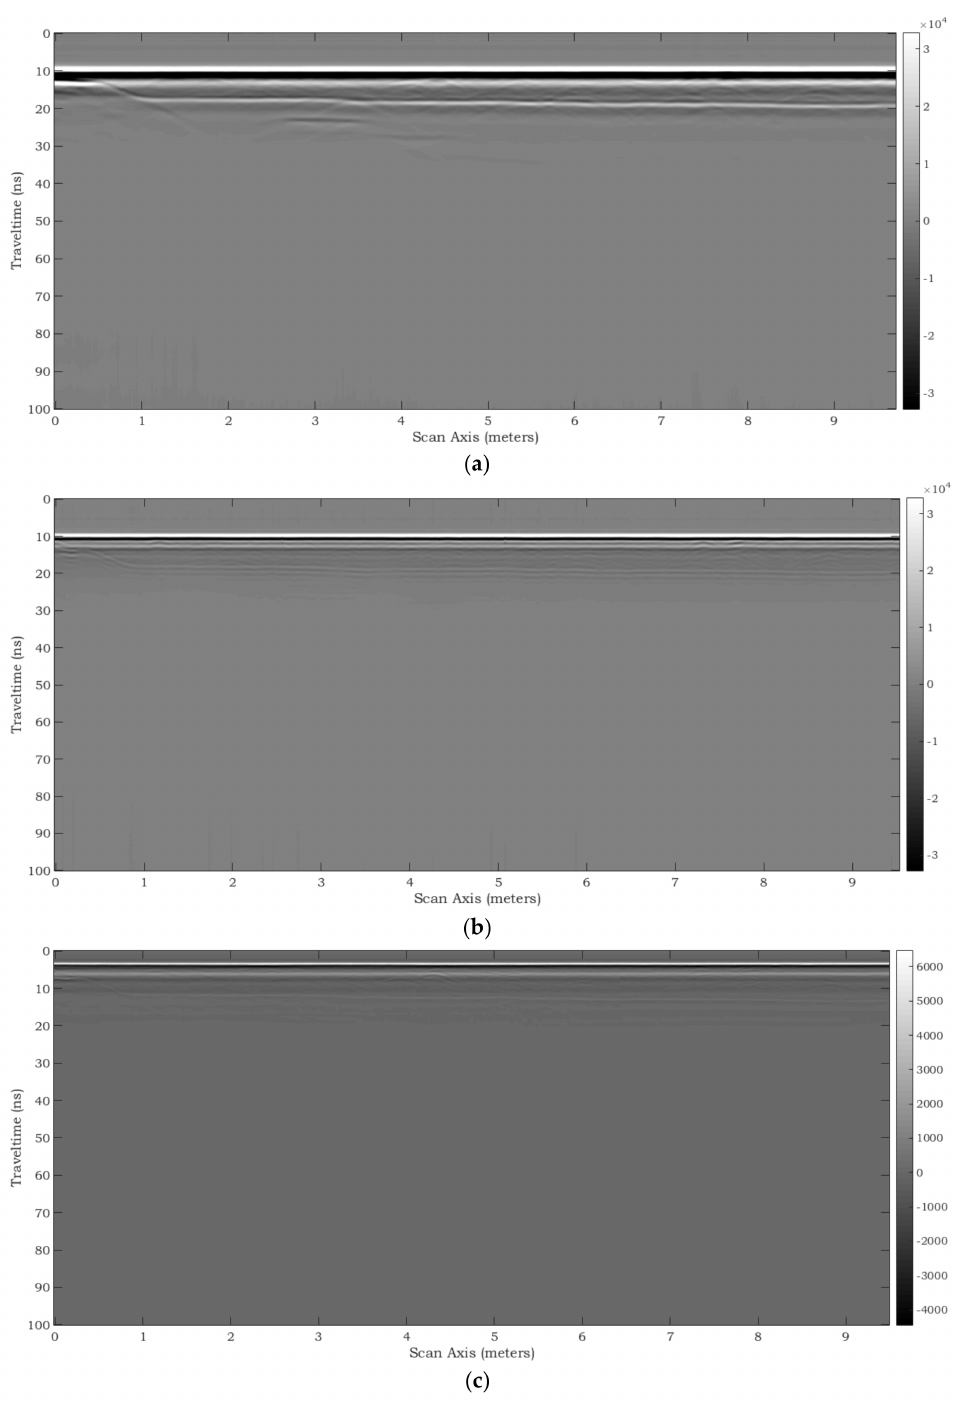
Figure 18. Profiles recorded in the silt region by using GPR 3, on acquisition line 1, with antennas operating at: ( a ) 200 MHz (data collected over a 9.7 m long portion of the acquisition line); ( b ) 600 MHz (9.52 m long portion of the acquisition line); ( c ) 900 MHz (9.48 m long portion of the acquisition